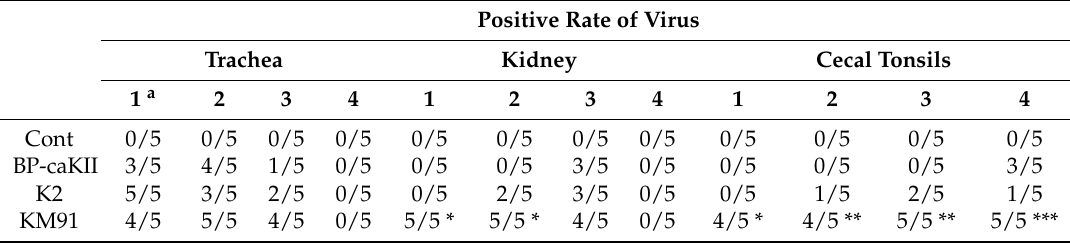
Table 3. Comparison of tissue tropism and persistency of infectious bronchitis viruses (IBVs).